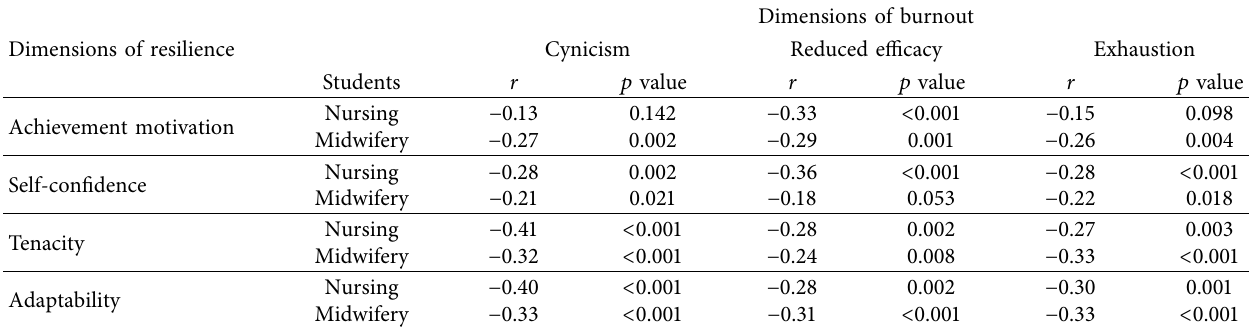
Table 3: Relationship between dimensions of resilience and burnout among nursing and midwifery students.